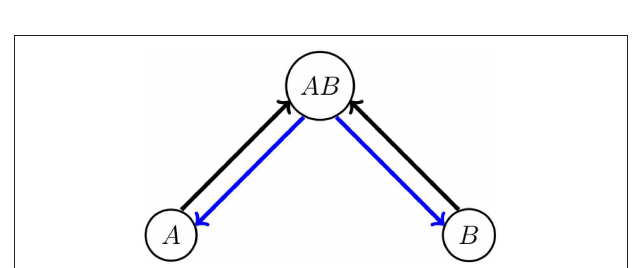
FIGURE 7 | Model scheme with two non-excluding options. Arrows indicate allowed transitions between the “bilingual” state ( A , B ) and the “monolingual” B transitions are not states A and B . Direct A ↔